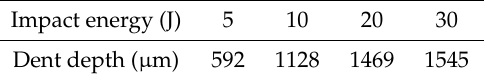
Table 3. Dent depth as a function of impact